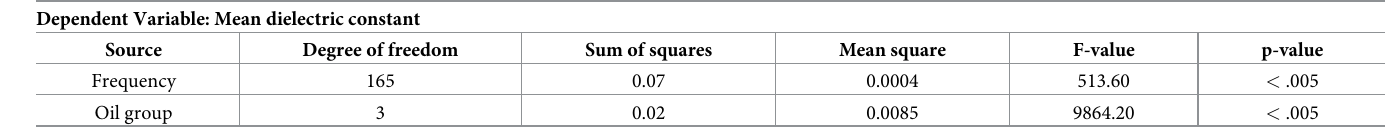
Table 3. Two-way ANOVA of the mean dielectric constant of vegetable oils.